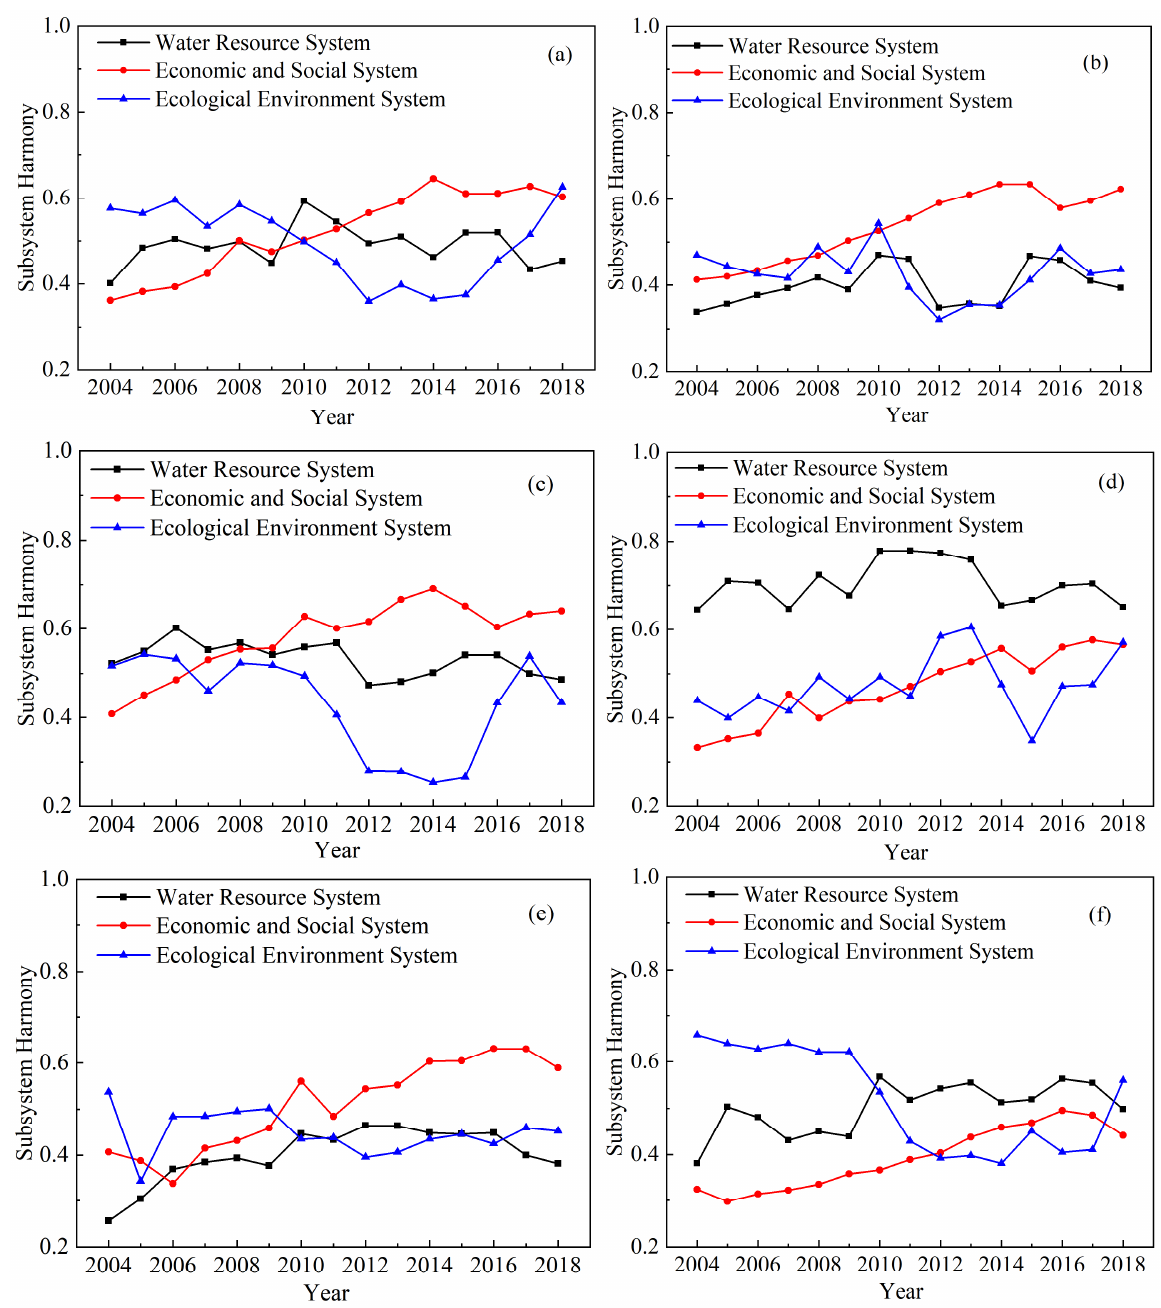
Figure 7. Trend of adaptation of each system in the TRB and the states. (a): trend of adaptation of each system in the TRB. ( b – f ): trend of adaptation of each system in the Aksu, BMAP , KKAP, KP, each system in the TRB. (b-f): trend of adaptation of each system in the Aksu, BMAP , KKAP, KP, and HP and HP regions.